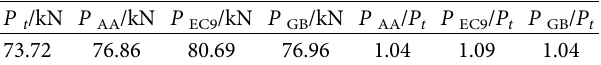
Figure 8: Typical load-strain relationships. Table 3: Comparison between calculation of specifications and test